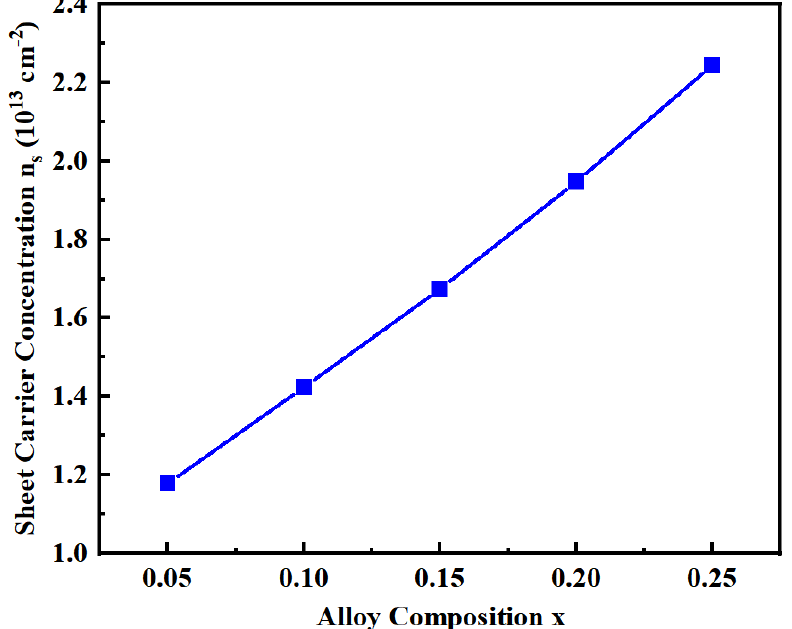
Figure 4. When d AlGaN = 20 nm, d In0.1Ga0.9N = 5 nm, and r = 0.5, the AlGaN barrier layer is fully strained, and the 2DEG concentration at the AlGaN/InGaN interface n s is at a different Al content.